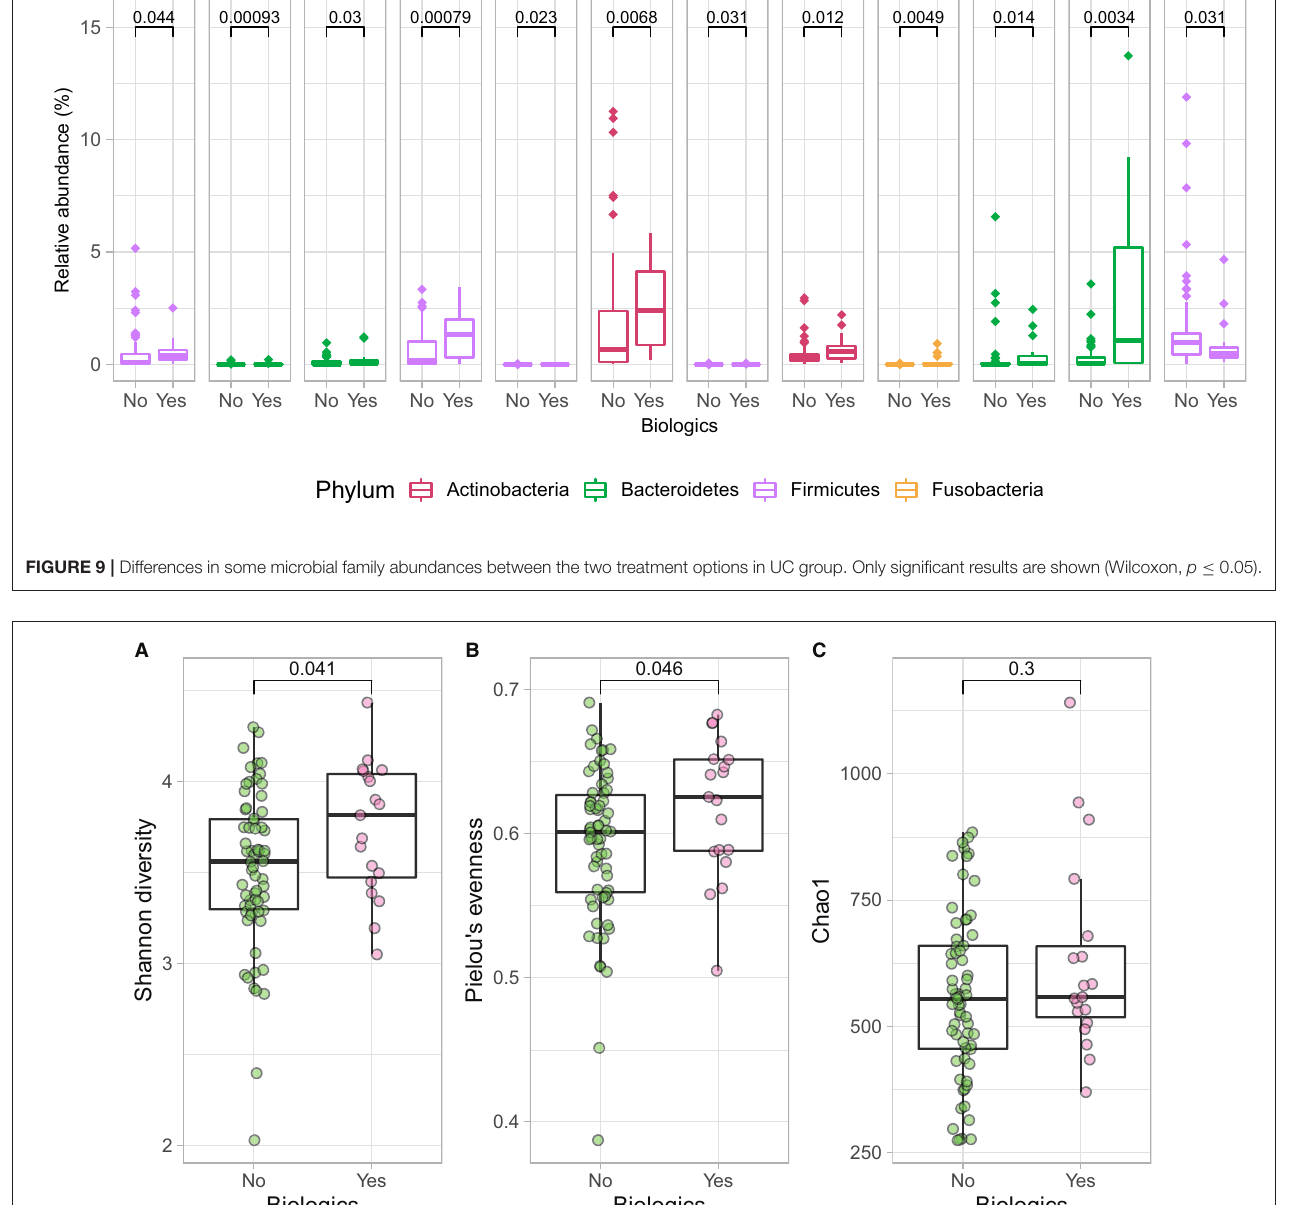
FIGURE 10 | UC participants- microbial a diversity and treatment modalities. Measures of microbial alpha diversity between treatment options in UC group (comprising remission and relapse) including: (A) Shannon’s index (diversity); (B) Pielou’s evenness; and (C) Chao1 index (richness).